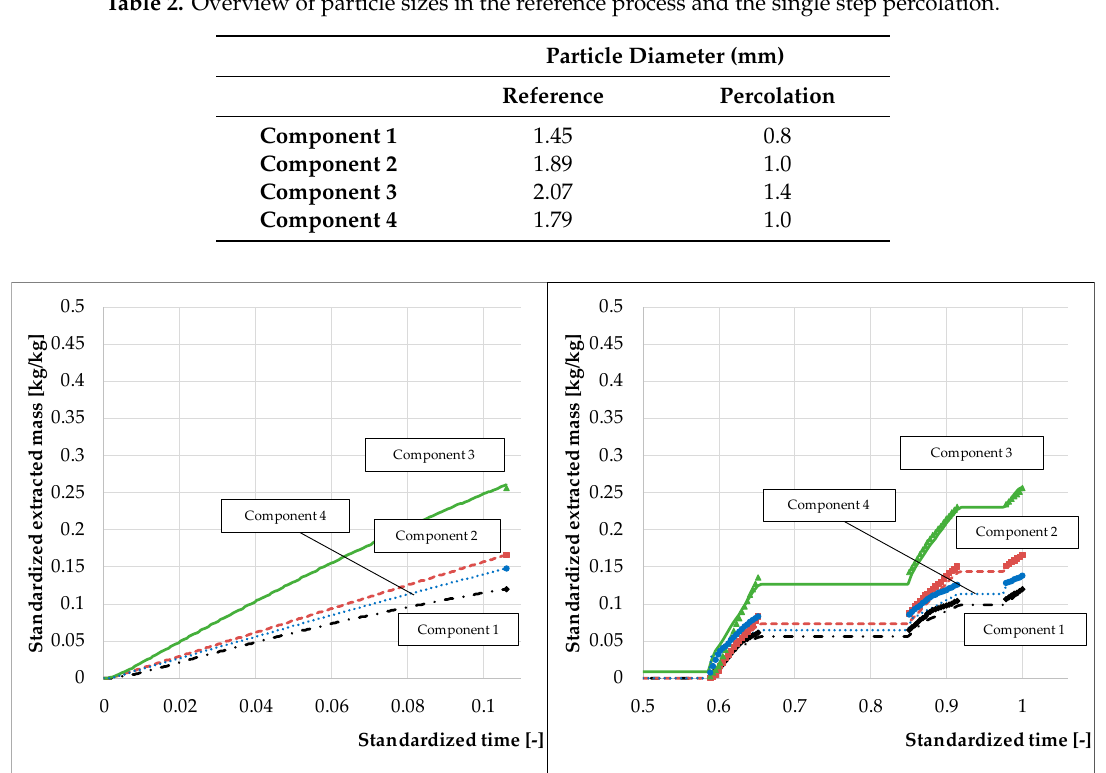
Figure 17. Comparison of the reference process (right) and a single step percolation (left) with constant product quality. Table 2. Overview of particle sizes in the reference process and the single step percolation.